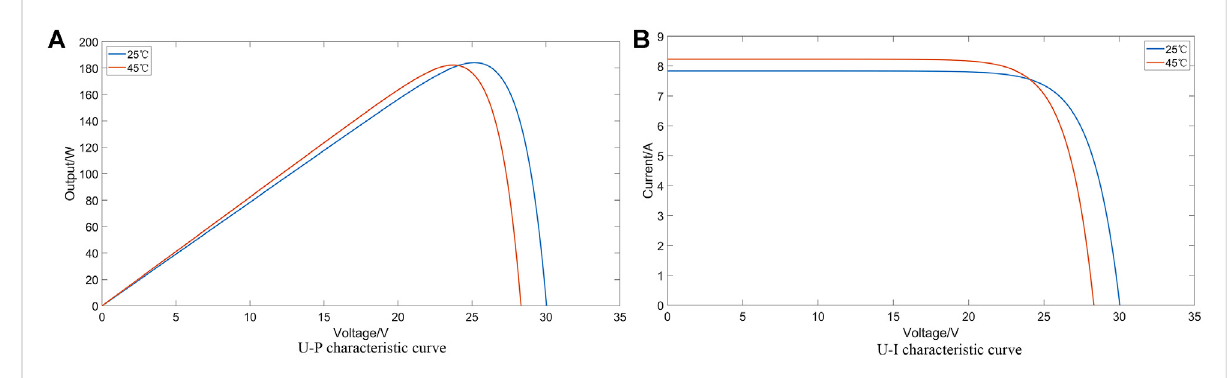
FIGURE 3 PV power generation system